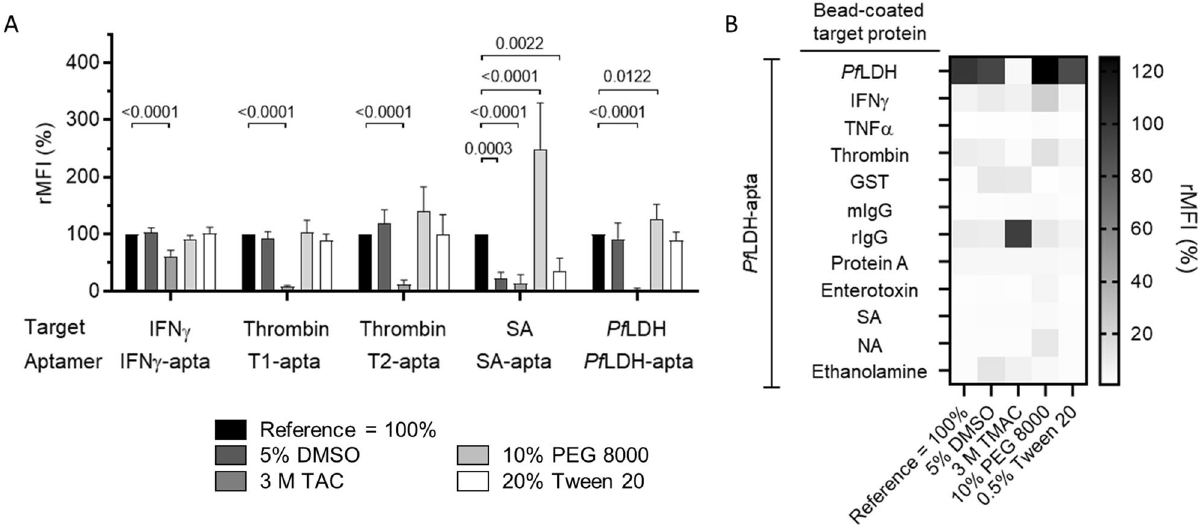
Figure 6. Influence of DMSO, PEG 800, TMAC and Tween 20 on aptamer binding. ( A ) Fluorescence-labelled microbeads coupled with either IFNγ, streptavidin, thrombin or Pf LDH were incubated with indicated aptamers. The streptavidin specific selection buffer functioned as a universal binding buffer supplemented with indicated components. ( B ) Heat map showing data of Pf LDH-apta to non-target proteins. The data of the other aptamers are shown in supplementary information (Supplementary Fig. S6). All data represented as mean ± SD (n =